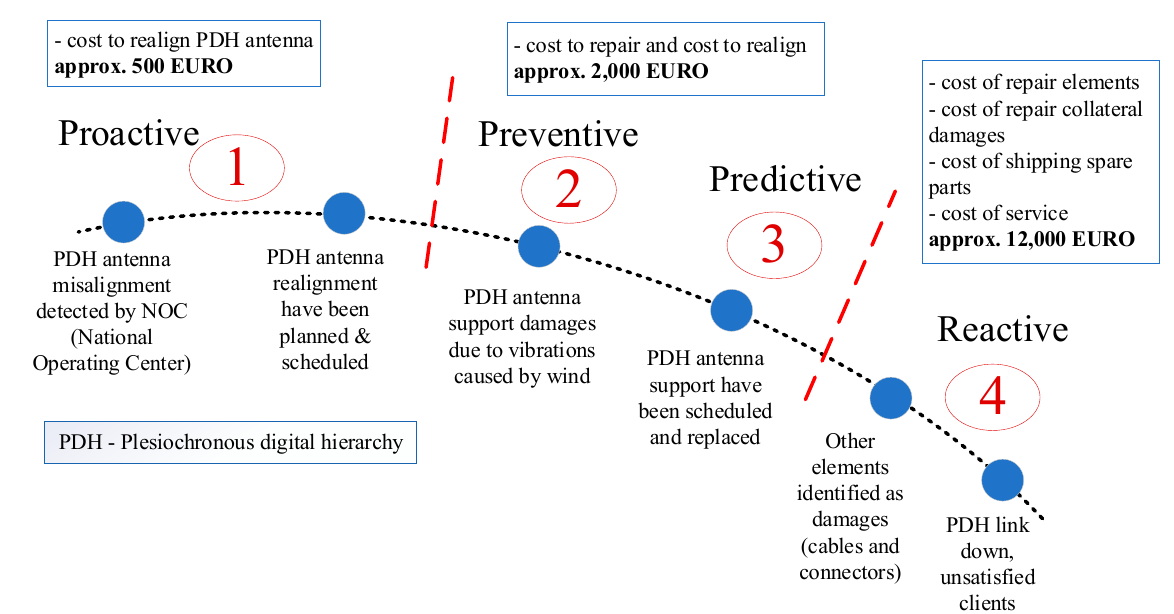
Figure 1 . Example of maintenance costs in telecommunications and potential-to-failure curve . Figure 1. Example of maintenance costs in telecommunications and potential-to-failure